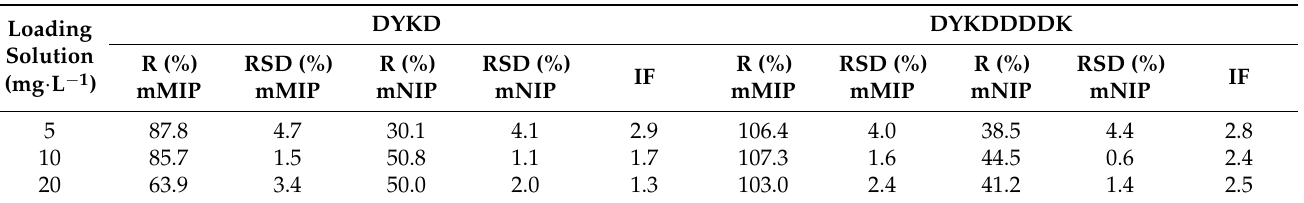
Table 3. Recovery rates (R, %), relative standard deviations (RSD, %) and imprinting factors (IF) of the peptides in the polymers synthesized in aqueous media.